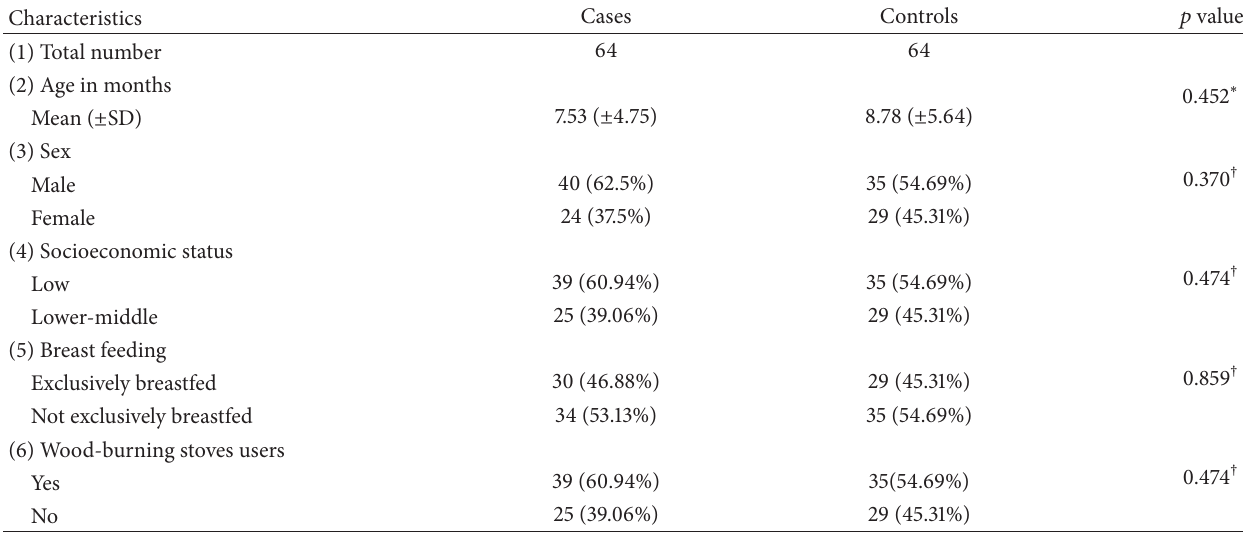
Table 1: Baseline characteristics of the cases and controls ( 𝑛 = 64 ).